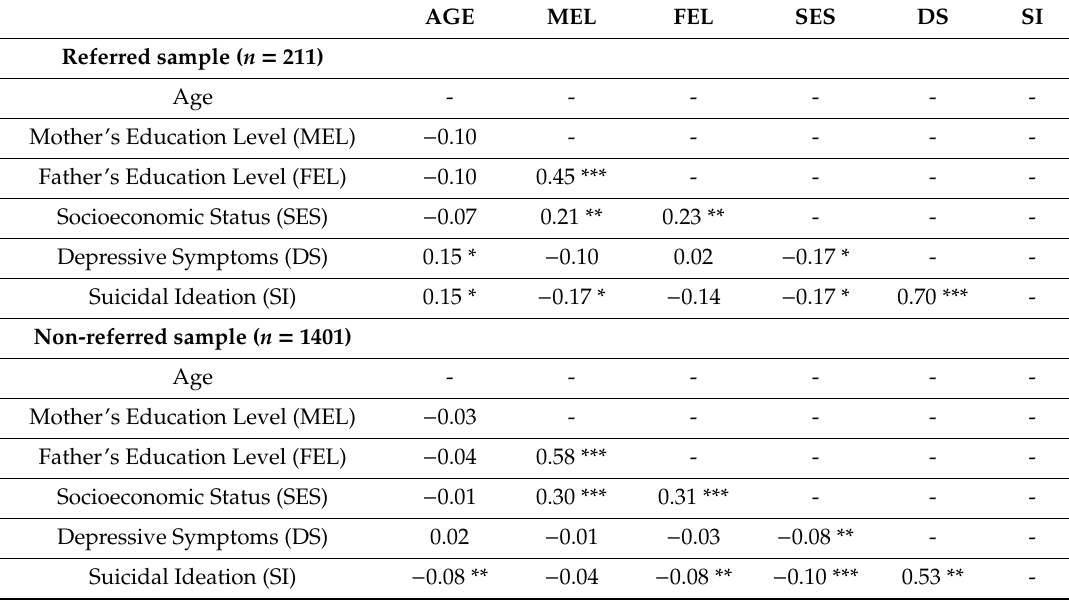
Table 2. Correlations among the demographic, social, and economic factors and internalizing problems for the referred ( n = 211) and the non-referred sample ( n =